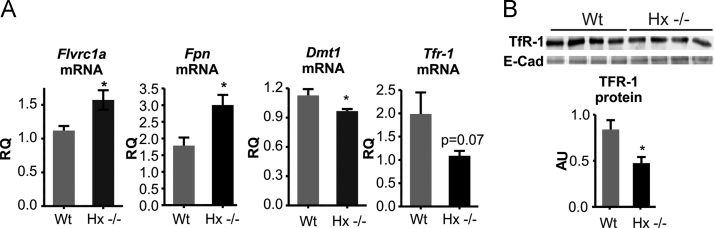
Hemopexin preserves heme homeostasis in the heart. Data on the heart of wild-type (Wt) and Hx-/- mice are shown. (A) qRT-PCR analysis of Flvcr1a, Fpn, Dmt1 and Tfr1 mRNA levels. (B) Western blot analysis of Tfr1 protein. Results shown are representative of 3 independent experiments. In B, each lane represents an individual animal; E-cadherin (E-Cad) was used as loading control. Unpaired t-test analysis with Welch׳s correction was performed. Values represent mean ± SEM. *P<0.05.